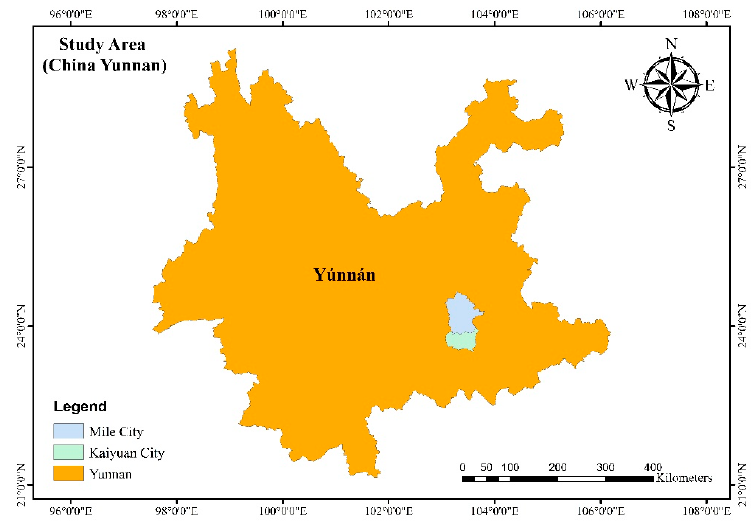
Figure 14. Study area.